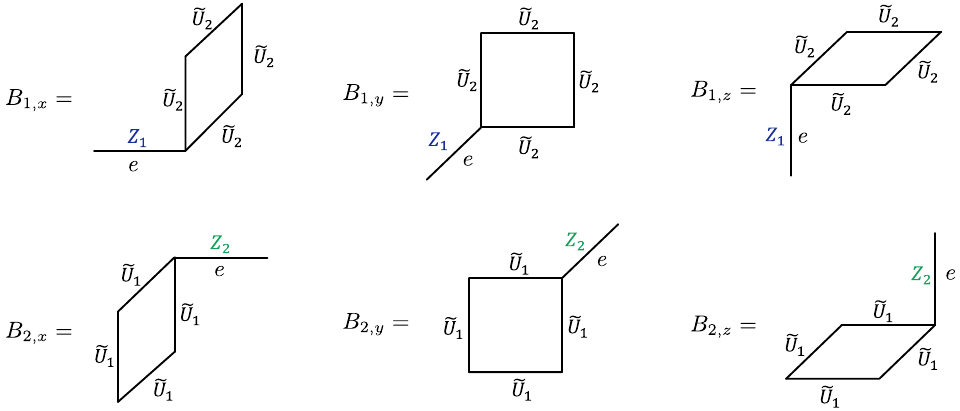
FIG. 7. The separators of Fig. 6 expressed using the fermionic hopping operators in Eqs. (E1) and (E2). We note that each separator is a single-site Pauli operator multiplied by a loop of fermion hopping